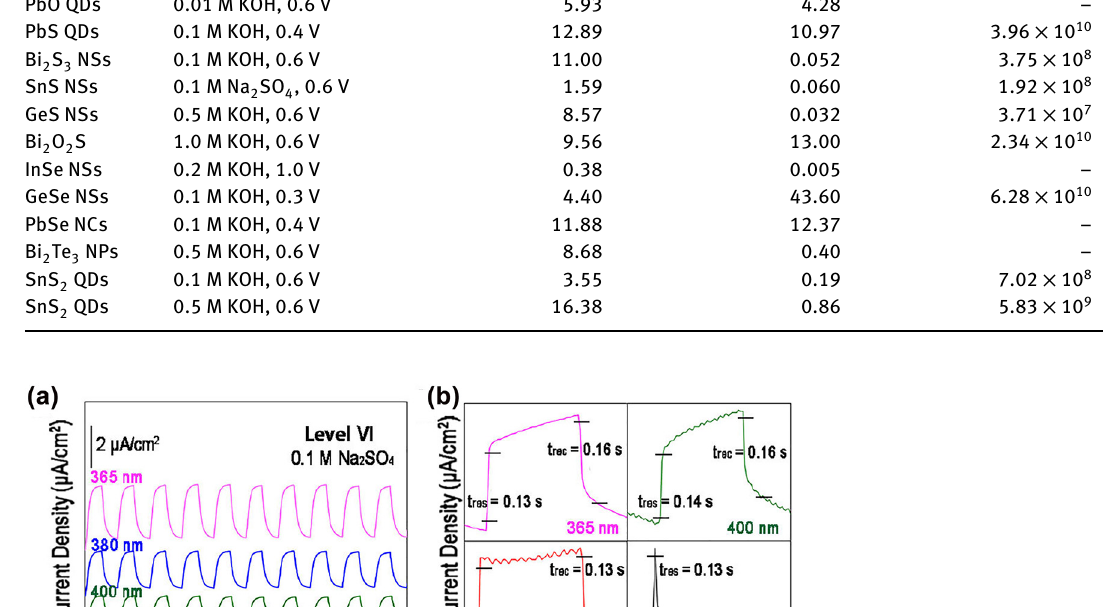
Figure 5: Photoresponse characteristics of QDs-basedphotodetectors.(a)Photore- SnS 2 sponse characteristics of SnS QDs-based 2 SO electrolyte at 0.6 PDs in 0.1M Na 2 4